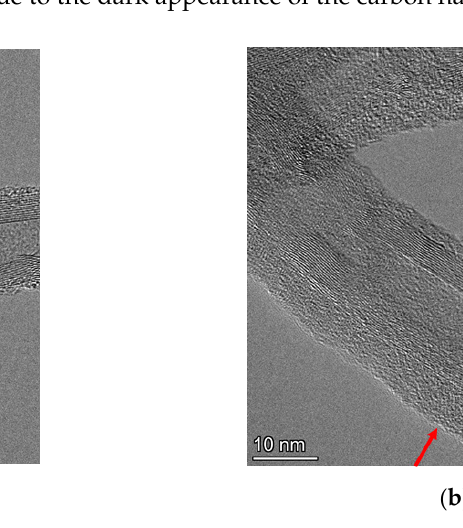
Figure 1. FTIR of MWCNTs, MWCNTs-PDA, MWCNTs-PDA-BiBB, and MWCNTs-PDA- PDMAEMA.